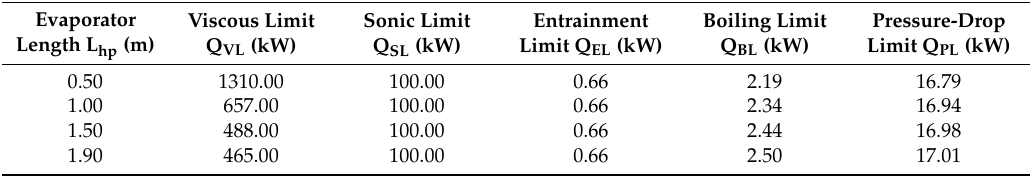
Table 7. Impact of the evaporator